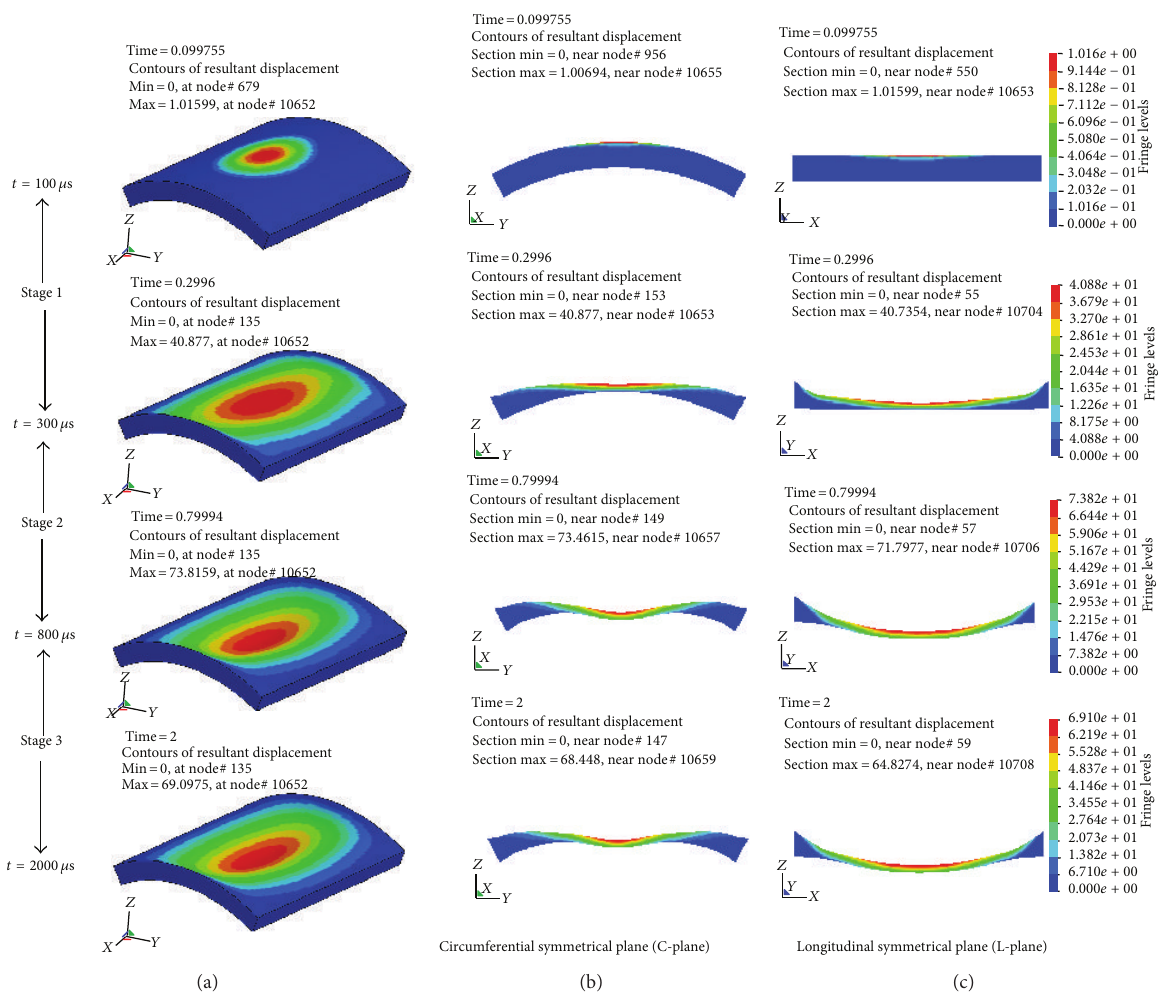
Figure 5: Simulated deformation and resultant displacement contours on (a) the sandwich panel, (b) the circumferential symmetrical plane, and (c) the longitudinal symmetrical plane at typical times after